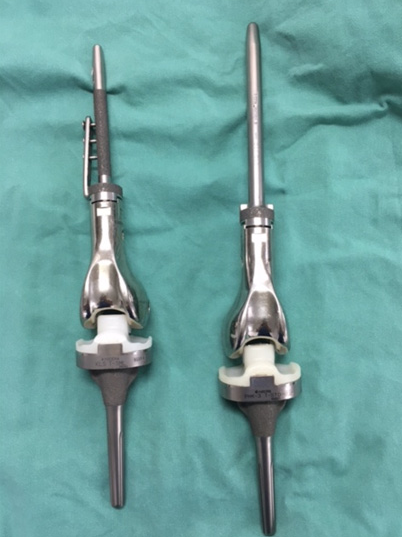
Figure 1. The detailed features of KMLS systems (Left, cementless system; Right, cement system). The cementless femoral stem has three unique non-penetrating holes and a side plate. The tibial component is the same in the cement and cementless types. The PHK III system is the same design as the KMLS cement system.